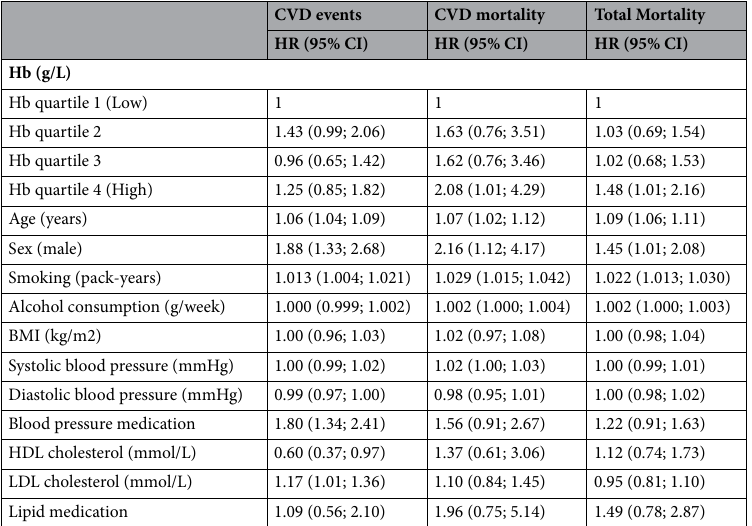
Table 3. Hazard ratios (HR) for cardiovascular disease (CVD) events, CVD mortality and total mortality according to Hb quartiles. Cox regression models representing HR with 95% confidence intervals (CIs)